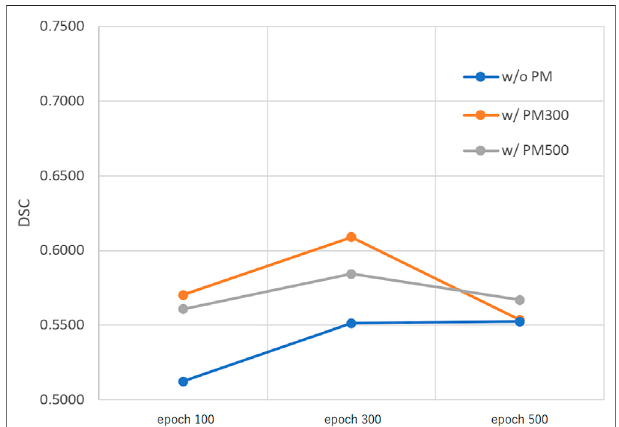
FIGURE 5 | Mean DSC of the test set when using Decathlon small . Abbreviation: PM, pretrained model; PM 300 , pretrained model obtained from 300epochsoftraining;PM 500 ,pretrainedmodelobtainedfrom500epochsof training.